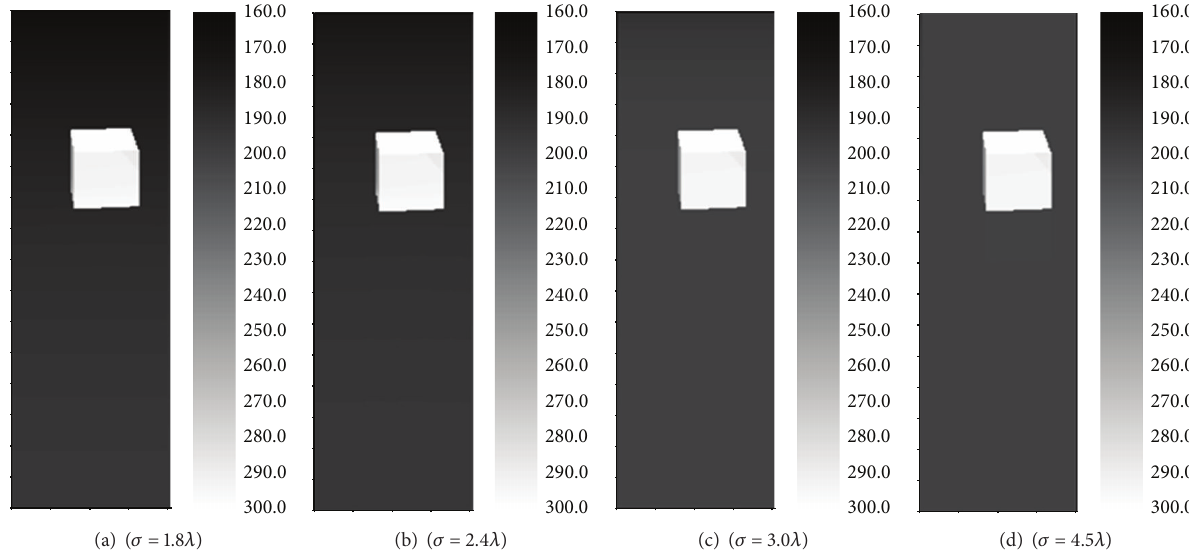
Figure 17: Simulated image of brightness temperature of four different types of grass roughness, in which the correlation length of 𝐿 is 10 𝜆 ; from (a) to (d), the RMS height of the rough surface is 1.8 𝜆 , 2.4 𝜆 , 3 𝜆 , and 4.5 𝜆 , respectively, which means that the roughness from (a) to (d) increases.